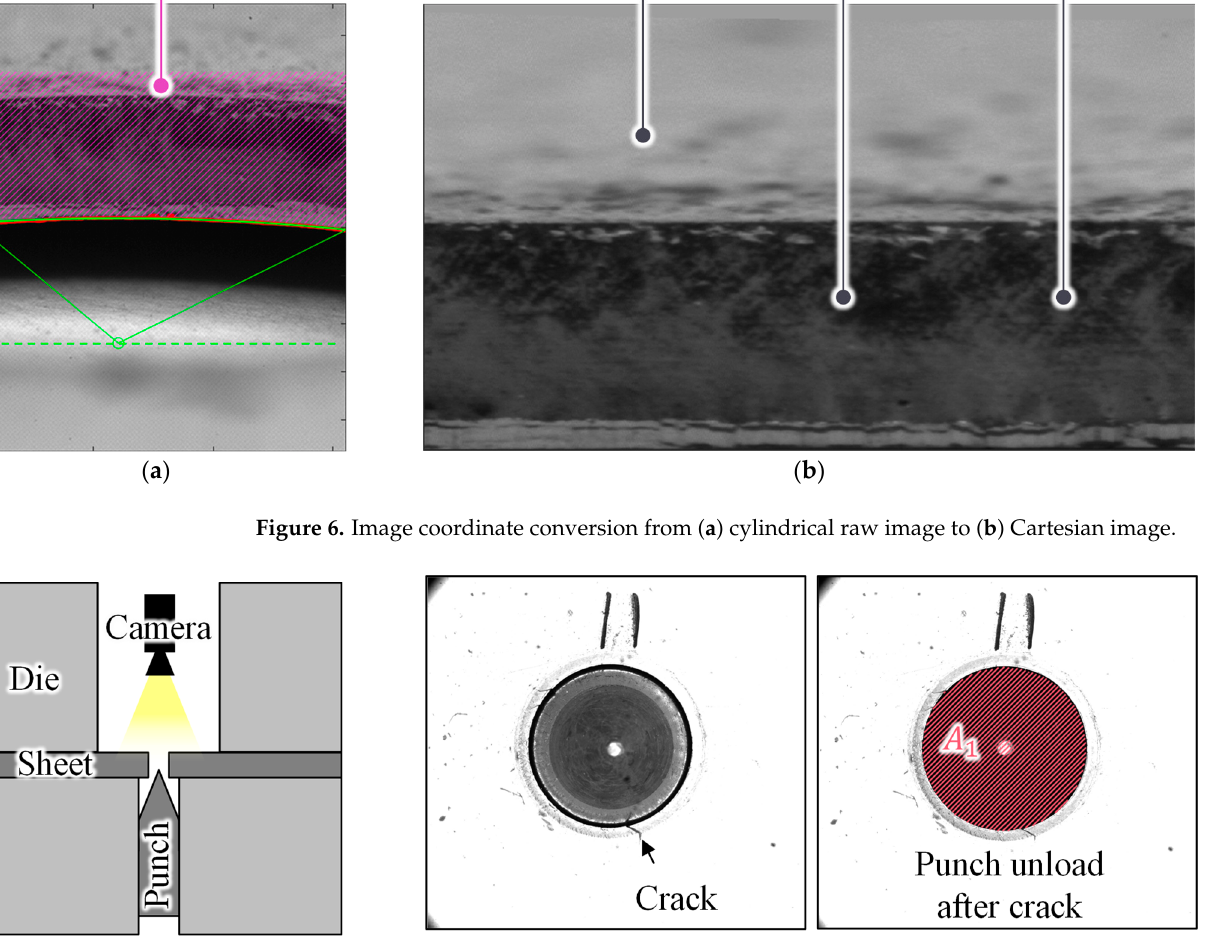
Figure 6. Image coordinate conversion from ( a ) cylindrical raw image to ( b ) Cartesian image.